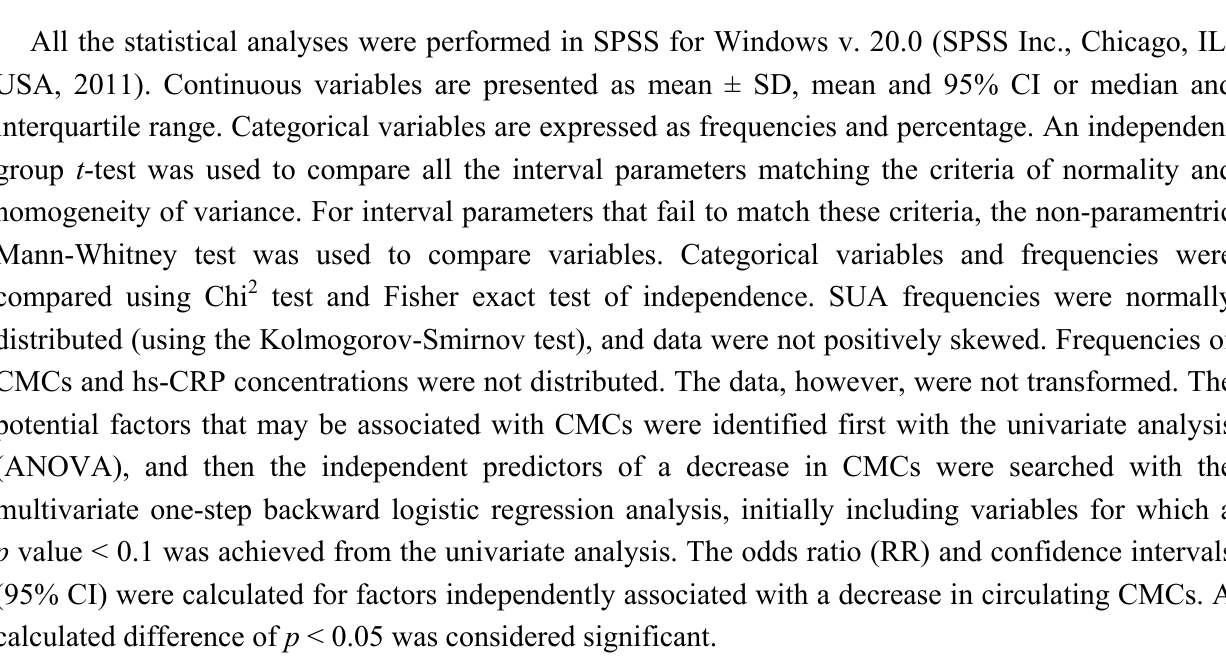
Table 2. Calcified atherosclerotic plaques were determined in 96% of patients; HD-NCP and LD-NCP were found in 31% and 25% respectively. The median of the Agatston score index was 586 (95% CI = 401–838). Coronary arteries with plaques were determined in 36.5%; 33.3%; and 20.2% for one vessel, two vessels, three and more vessels